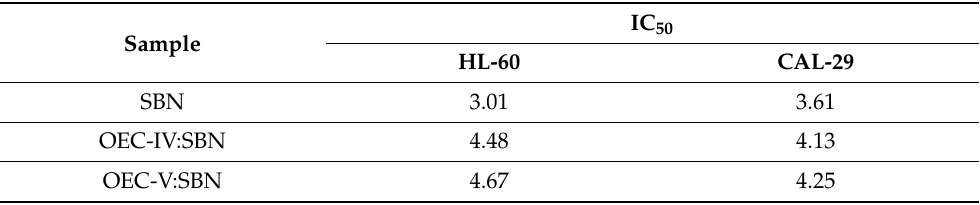
Table 4. IC 50 values of free and loaded silibinin ( µ